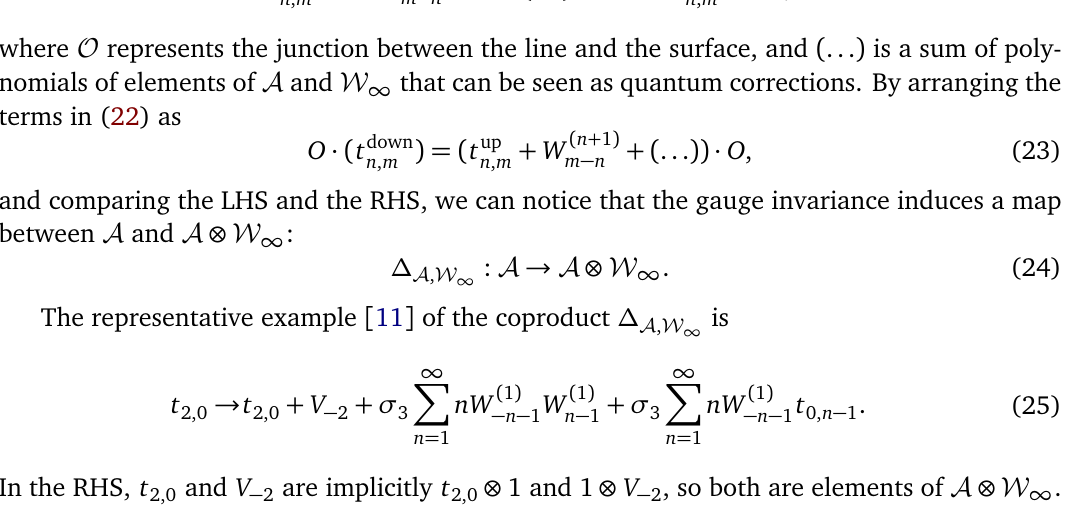
. A , W ∞ , A . d is a combinatorial factor that depends on m m , n 1 2